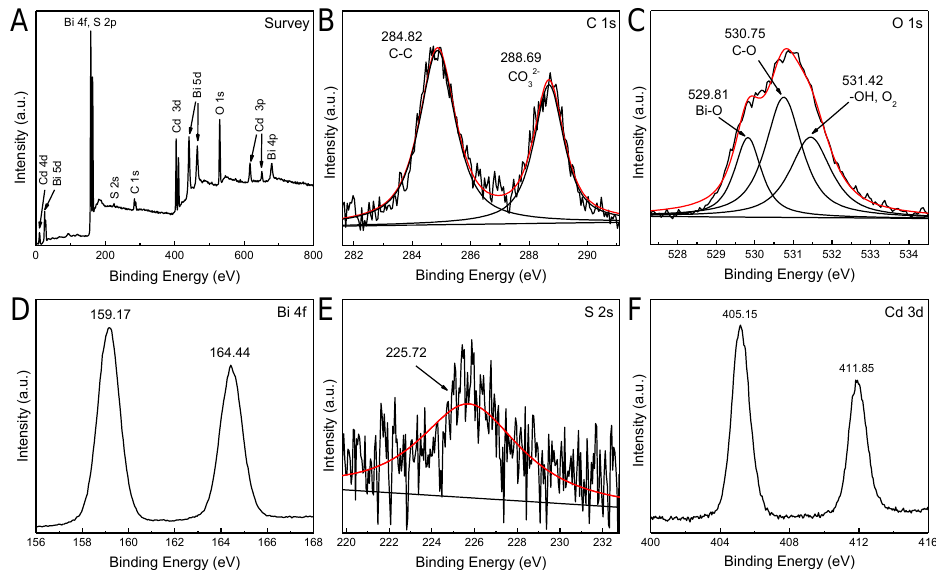
Figure 5. XPS spectra of the prepared Bi 2 O 2 CO 3 /CdS QDs-10 photocatalyst: the total survey ( A ), C 1s ( B ), O 1s ( C ), Bi 4f ( D ), S 2p ( E ), Cd 3d ( F ) XPS core level spectra.